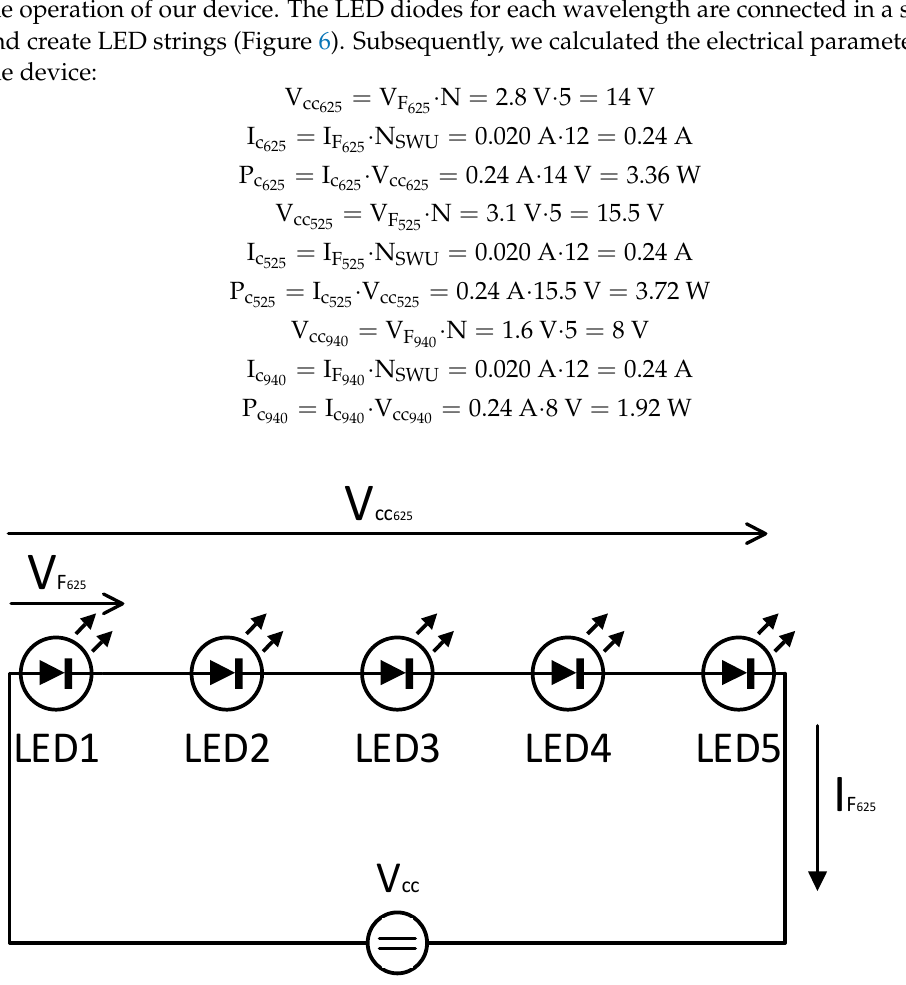
Figure 6. Connection of one LED string.